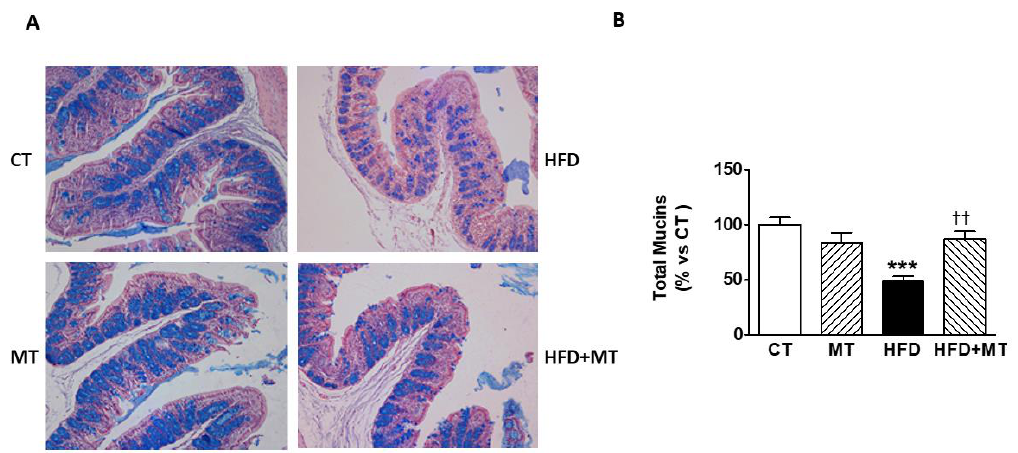
Figure 2. ( A ) Representative microphotographs and ( B ) quantification of total mucin levels in colon from control animals fed a normal chow (CT) and animals fed a high fat diet (HFD) treated with vehicle or with the mitochondrial antioxidant MitoTempo (MT; 0.7 mg / Kg / day i.p) stained with Alcian Blue (AB) / periodic acid-Schi ff (PAS) examined by light microscopy (magnification 20 × ). Bar graphs represent the mean ± SEM of 5–6 animals normalized to for CT group. *** p < 0.001 vs. CT group; †† p < 0.01 vs. HFD group.